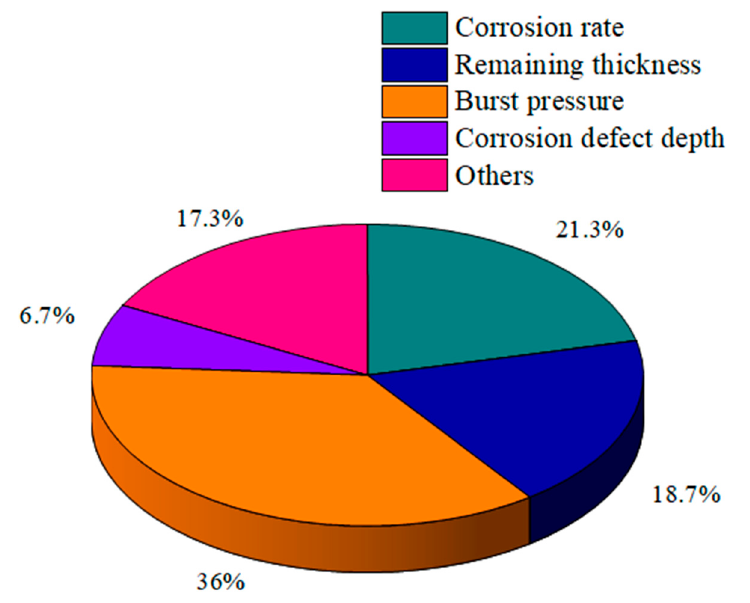
Figure 13. Output value of 71 models.